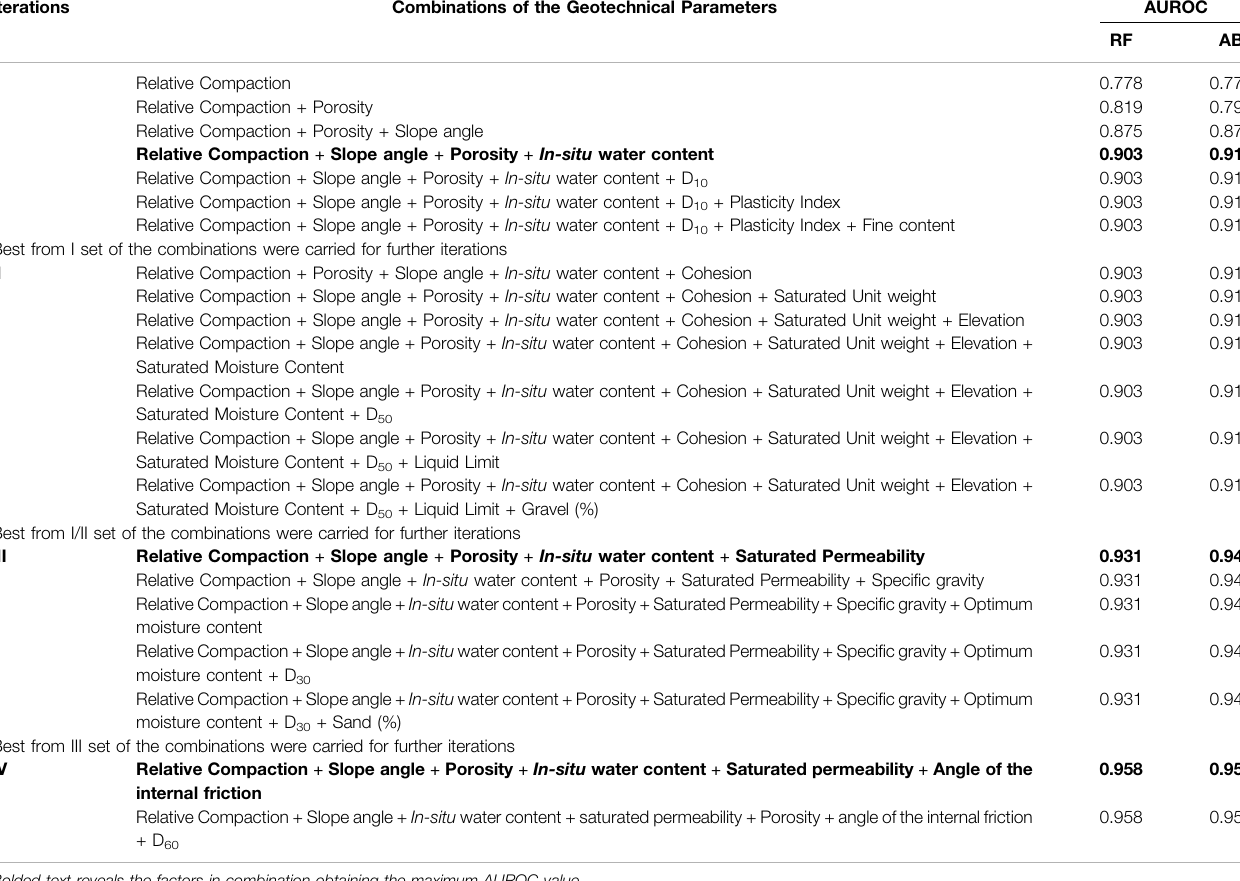
TABLE 9 | AUROC values for selected factor combinations in different iterations involving the RF and AB techniques. Iterations Combinations of the Geotechnical